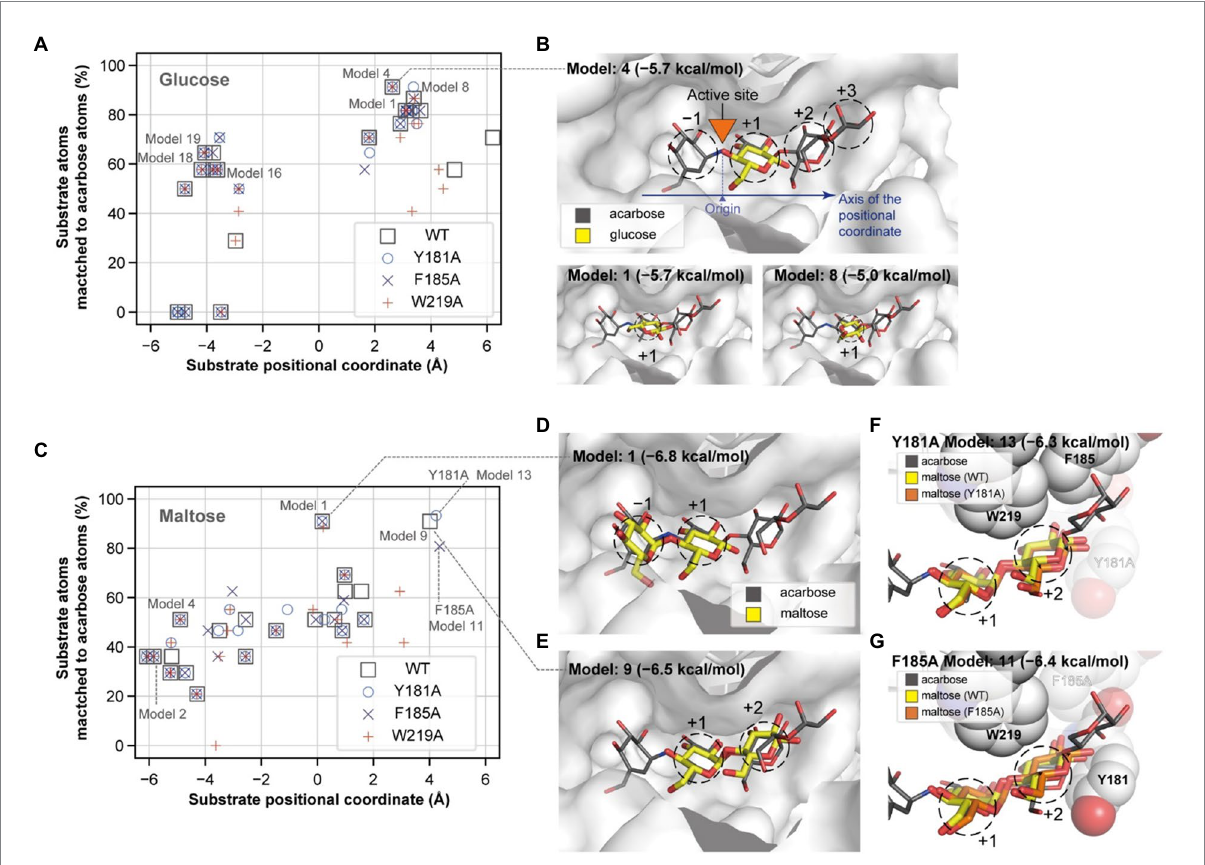
FIGURE 7 Glucose and maltose docking conformations. The docking positions of a glucose (A) and a maltose (C) molecule and their degrees of match to the inhibitor molecule are plotted for the wildtype and mutant PSGT structure models. The substrate positional coordinate in (A,C) is the projection of the center of heavy atom coordinates onto the axis of the substrate binding site, which is shown by the blue arrow in (B) . The position of the acarbose atom linking the two moieties in the − 1 and + 1 positions in (B) was used as the origin of the coordinate. (B,D,E) The three- dimensional structures of the docking conformations are illustrated as yellow sticks on the surface of the enzyme, along with the structure of acarbose (in gray narrow sticks), AutoDock Vina docking scores, and the model number, which represents the rank of the docking score. (F,G) Docking conformation on the +1 and + 2 subsites of the Y181A and F185A variant structure models. Y181, F185, and W219 are shown as spheres, but the alanine substitute residues are displayed in translucent